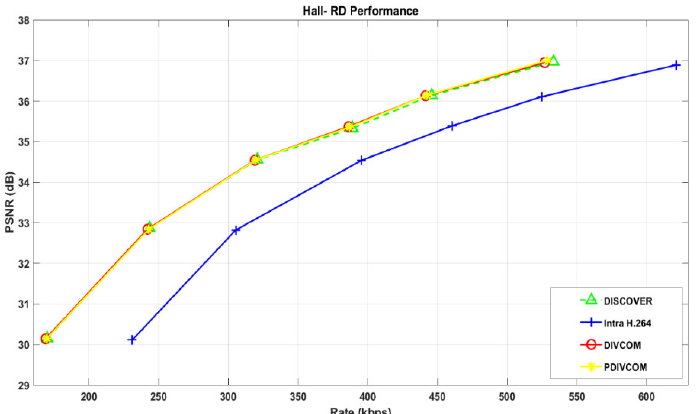
Figure 5. Rate-distortion (RD) performance of “Hall” video sequence with frame rate of 15 Hz and GOP 2.